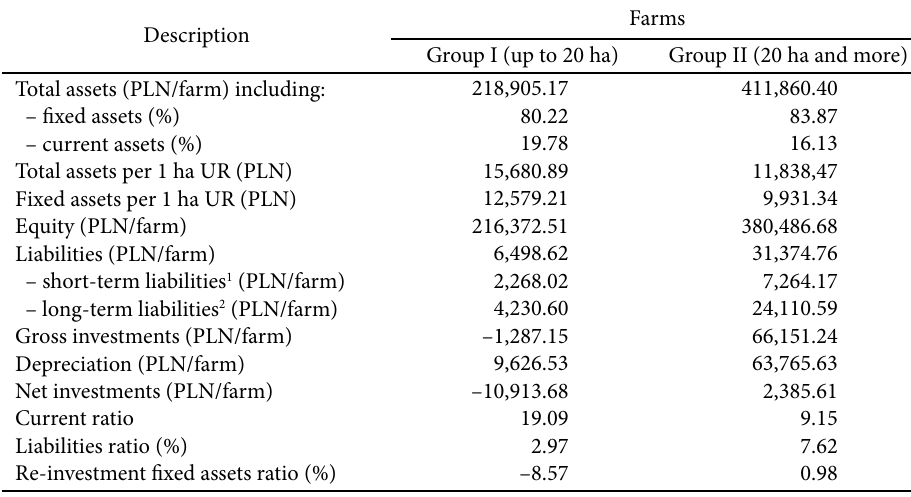
Table 6. Characteristics of the property and the financial position of organic farms in the years 2008–2012 (per farm) Farms Description Group I (up to 20 ha) Group II (20 ha and more) Total assets (PLN/farm)